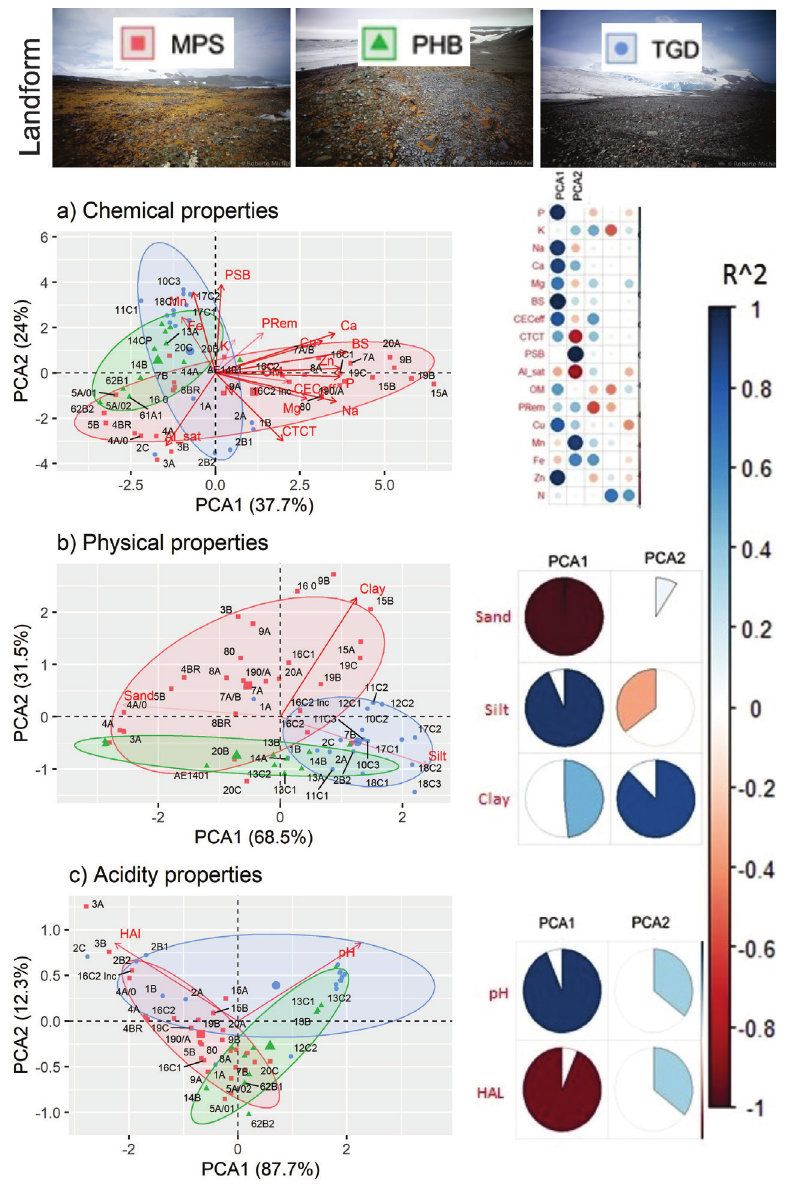
Figure 4. Principal component analysis